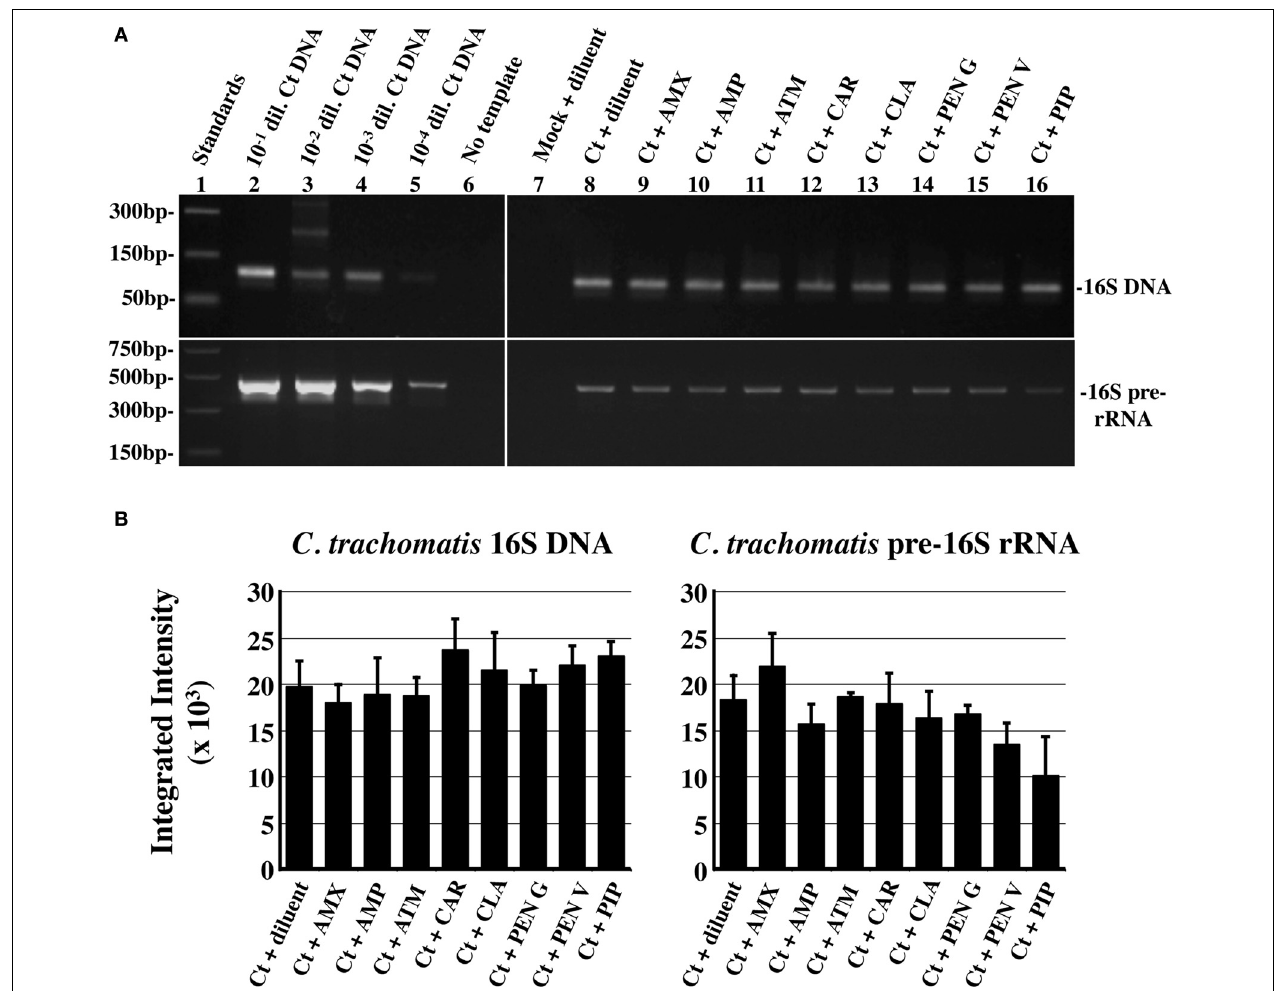
FIGURE 4 | Penicillin-exposure does not reduce genomic DNA or pre-16S rRNA accumulation. Total DNA and RNA from 1X antibiotic-exposed, infected cells was subjected to semi-quantitative PCR (or RT-PCR) using primers specific for human GAPDH (DNA), chlamydial 16S rRNA (DNA), and chlamydial unprocessed 16S rRNA transcripts (RNA). (A) Representative PCR gel images. Amplification of + control DNA dilutions are shown to the left.